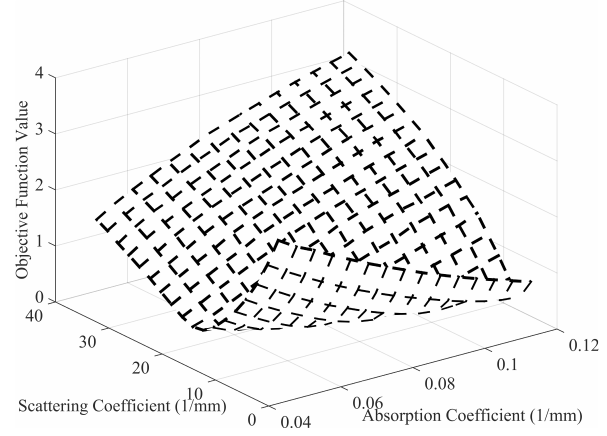
Fig. 6. The obtained objective function values for various scattering coe±cients. The objective function is the smallest when (cid:1) a ¼ 0 : 075 mm (cid:4) 1 and (cid:1) s ¼ 13 : 0 mm (cid:4) 1